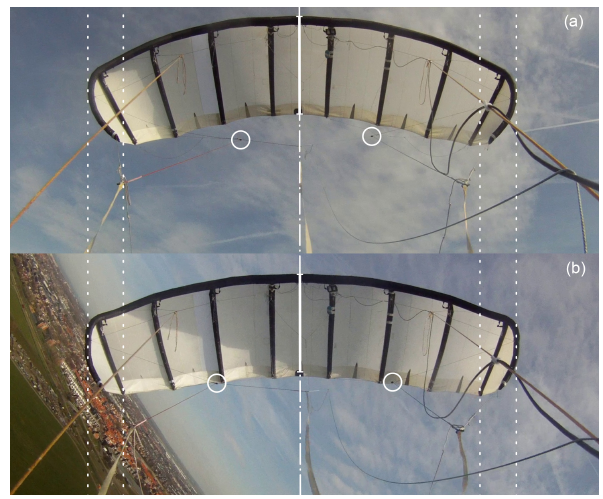
Figure 9. Depowered kite ( a ) and powered kite ( b ) from a video camera mounted on the KCU and looking into the wing. The video sequence of the entire maneuver is available from Schmehl and Oehler